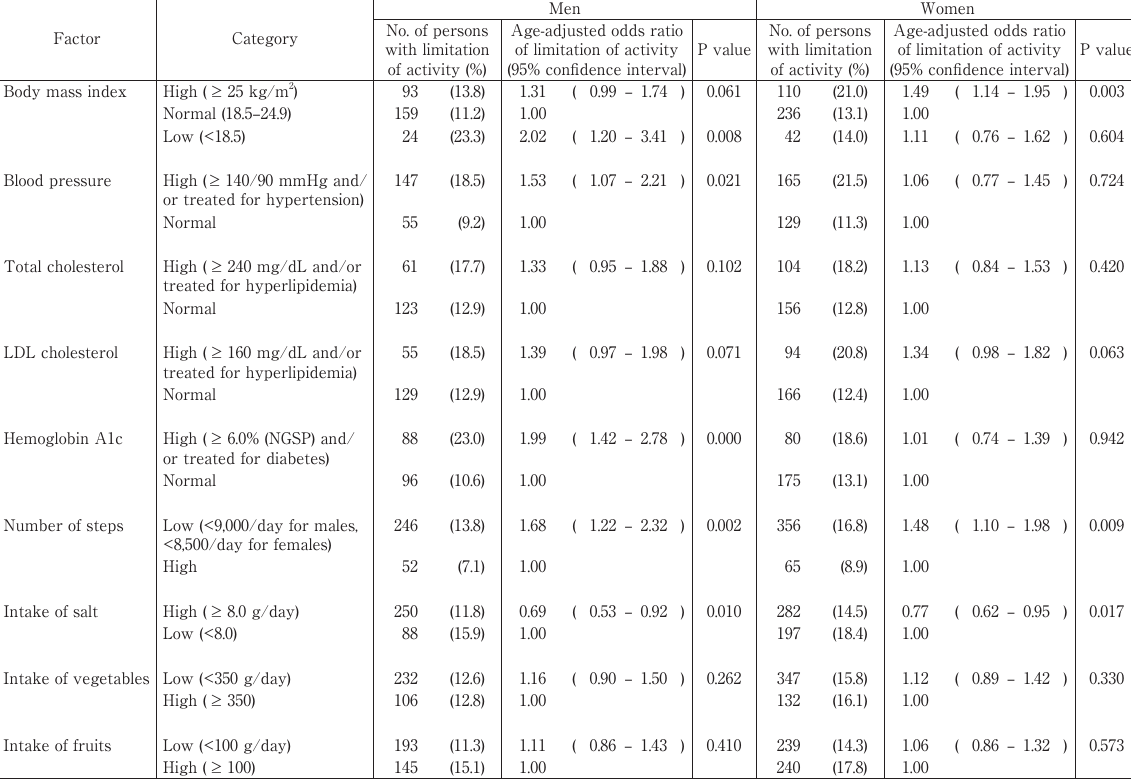
Table 2. Age-adjusted odds ratios of limitation of activity for assessed factors